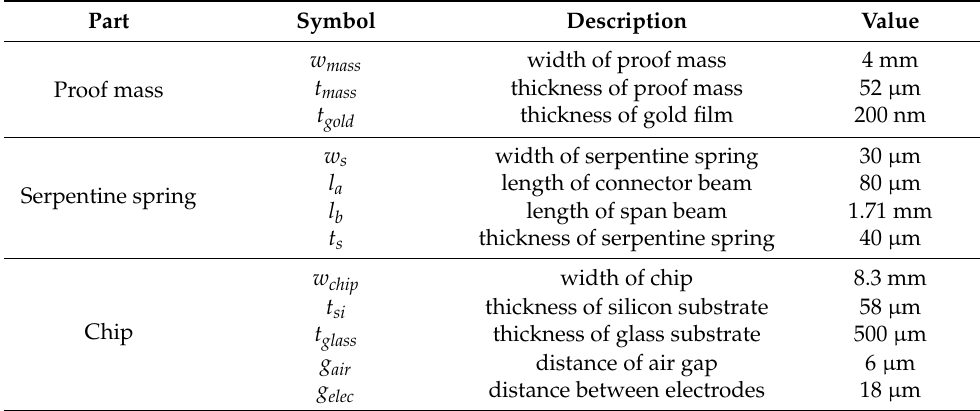
Table 1. Design parameter values for the vertical MEMS